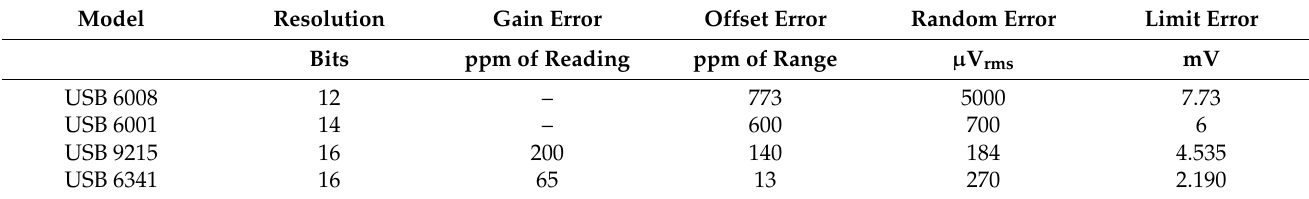
Table 1. Parameters of tested measurement modules for ±10 V differential range.